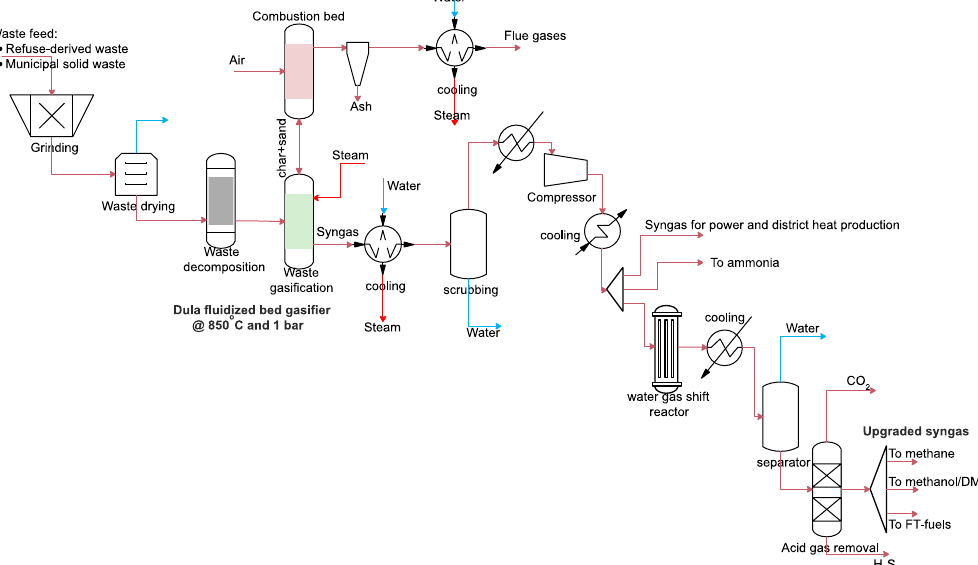
Figure 4. Process flow diagram of gasification of MSW and RDF in the indirectly heated DFBG.